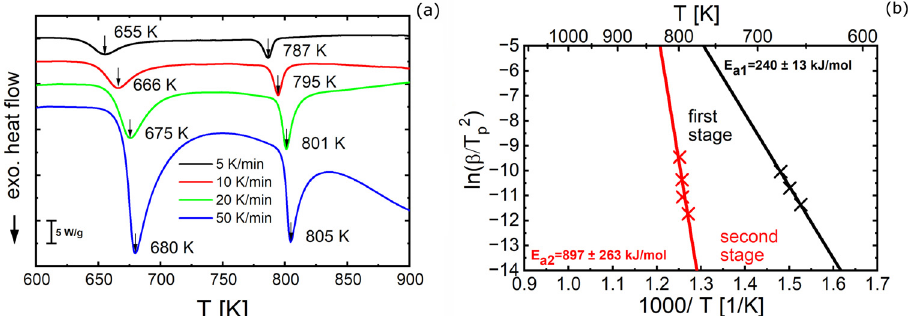
Figure 7. DSC measurements for alloy B (Fe 81.2 Co 4 Si 0.5 B 9.5 P 4 Cu 0.8 ) before HPT deformation ( a ) DSC scans obtained at different heating rates (5, 10, 20, and 50 K/min) and ( b ) Kissinger plots for determination of the activation enthalpies E (ai) for both crystallization stages. B denotes the heating rate in K/min and T p the local minimum of the respective stage of crystallization for that heating rate.